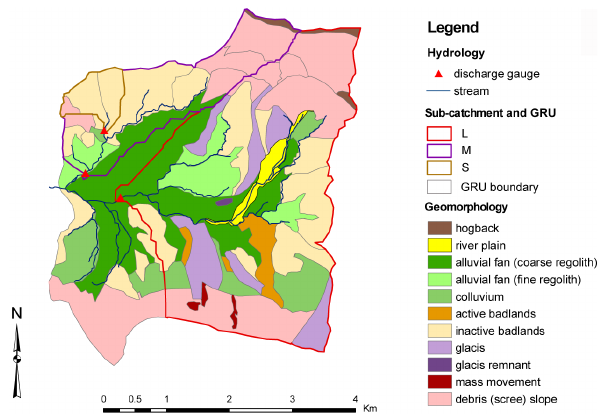
Fig. 3. Vegetation characteristics of the catchment.